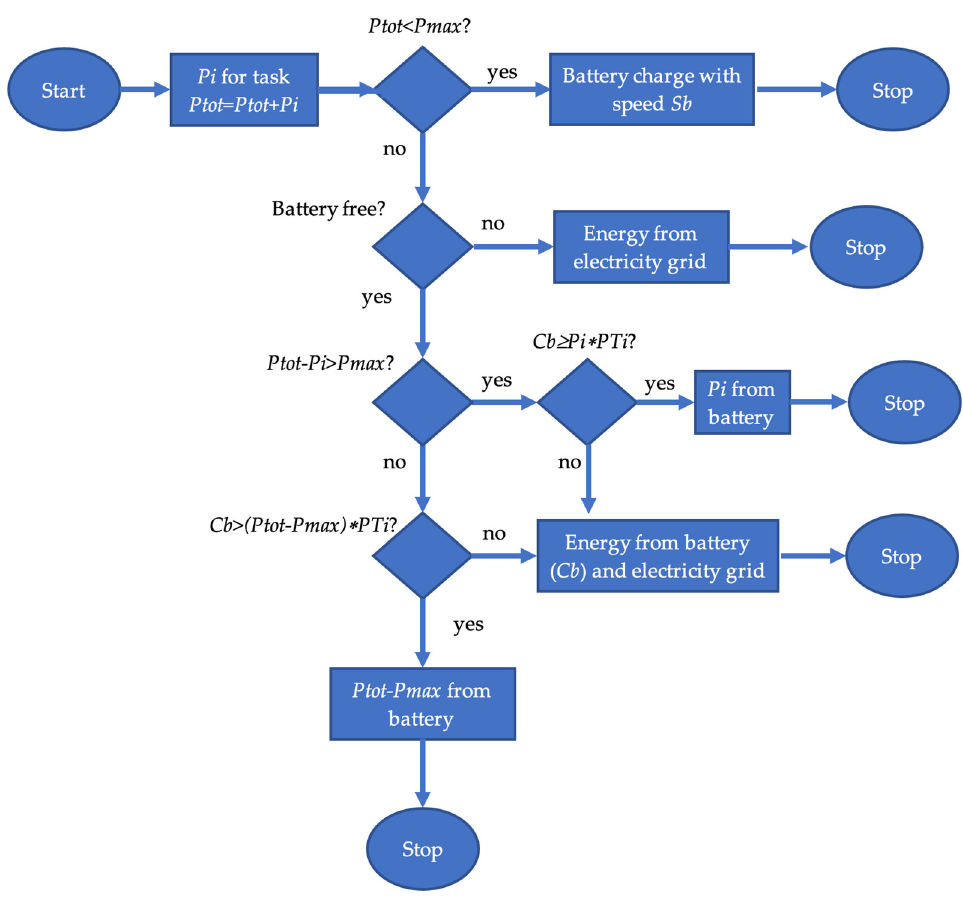
Figure 1. Machine controller activities on enter item.